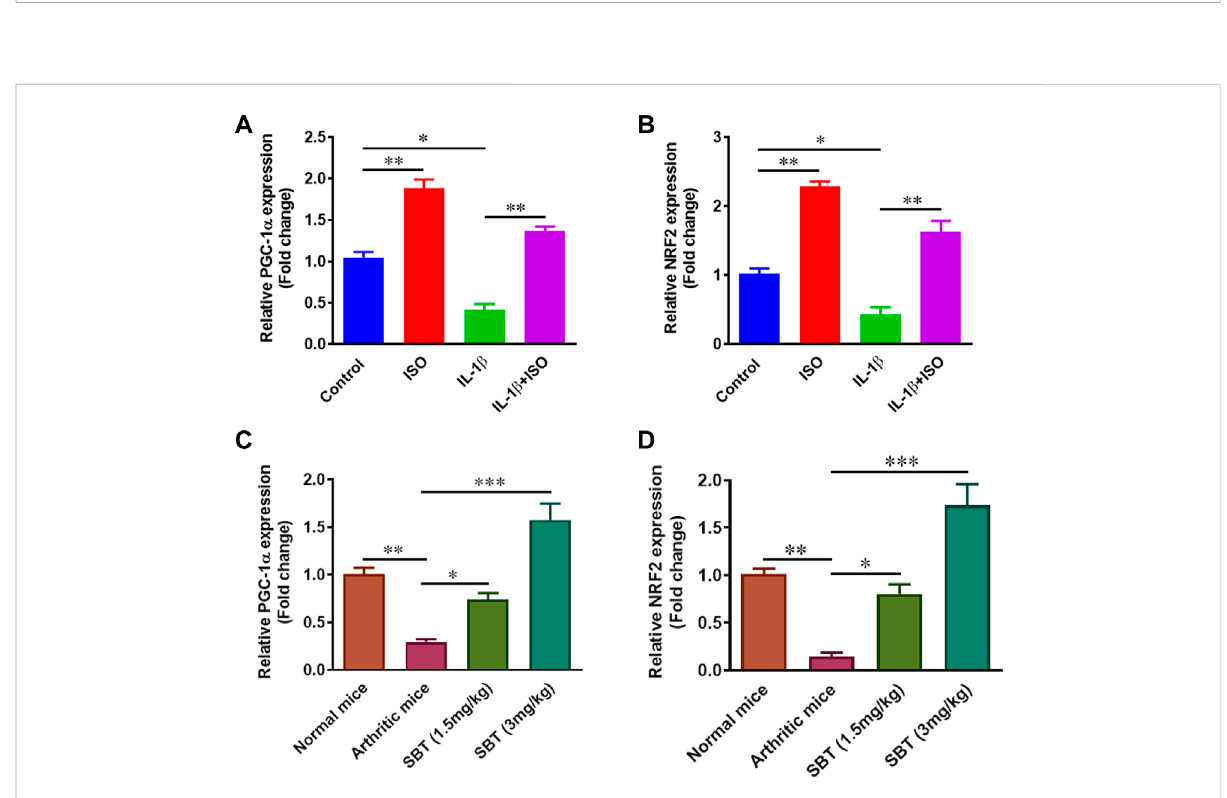
FIGURE 7 Mitochondrial biogenesis regulation analysis in vitro and in vivo . CHON-001 cells were treated with ISO (10 − 5 mol/L), IL-1 β (10 ng/ml) or combination of both for 24 h. Quantitative-PCR was performed to analyze relative expression of PGC-1 α (A) and NRF2 (B) . Relative gene expression analysis of PGC-1 α (C) and NRF2 (D) in murine chondrocyte by using qPCR. All experiments were performed in duplicates. Data were analyzed by GraphPad prism version 7.0. Signi fi cance of data was measured by using One Way ANOVA. * p < 0.05, ** p < 0.01, *** p <